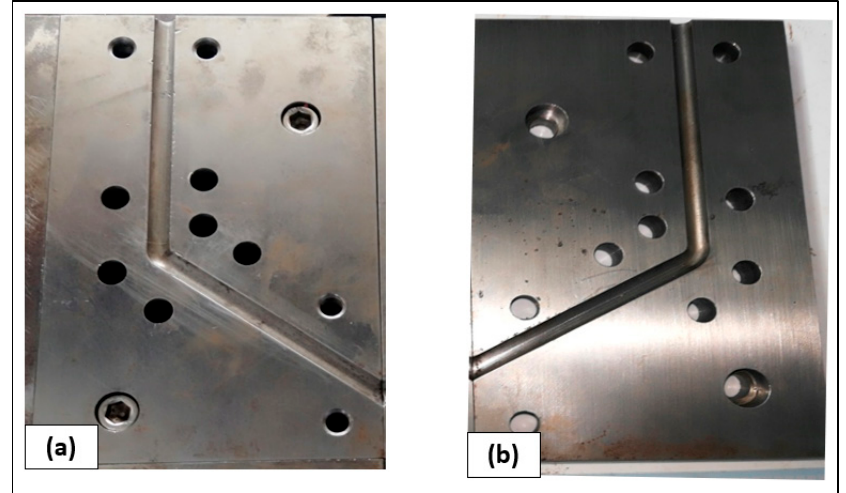
Figure 1. Insert of ECAP die with internal die angle of ( a ) 120° and ( b ) 126° . For microstructure analysis, a metallurgical microscope (Olympus BX53, Melville, NY, USA) was used. The image of the microstructure appeared after being etched using Carpenters stainless steel etch. Only one of each condition was tested. Toupview software (Hangzhou ToupTek Photonics Co., Ltd., Zhejiang, China) was used to further analysis of grain size and particles area.